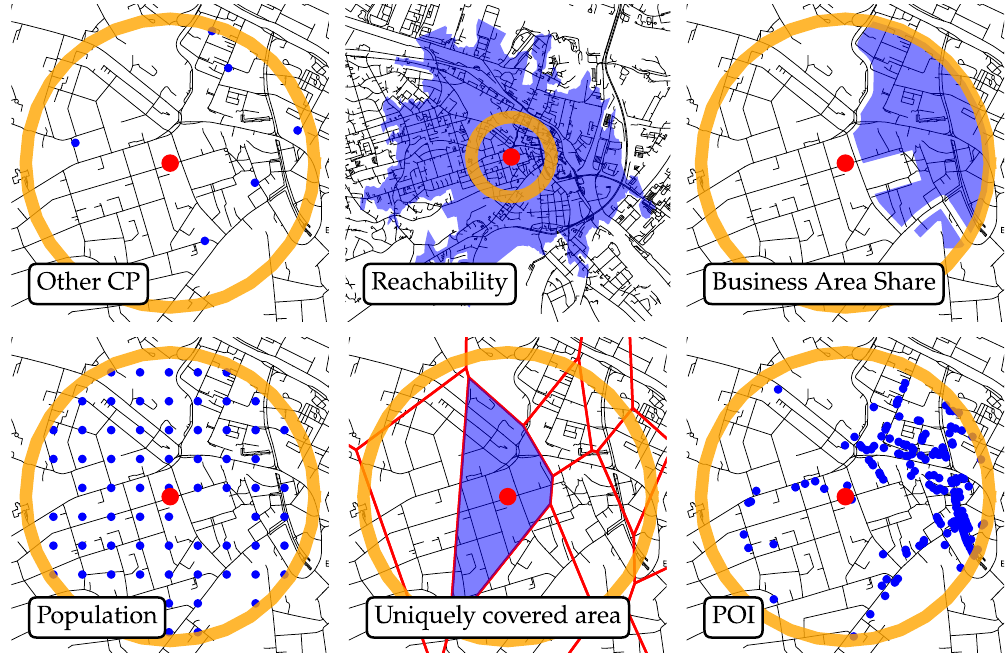
Figure 5. Visualization of metrics used in the case study. Orange circles serve as a size reference (500 m radius